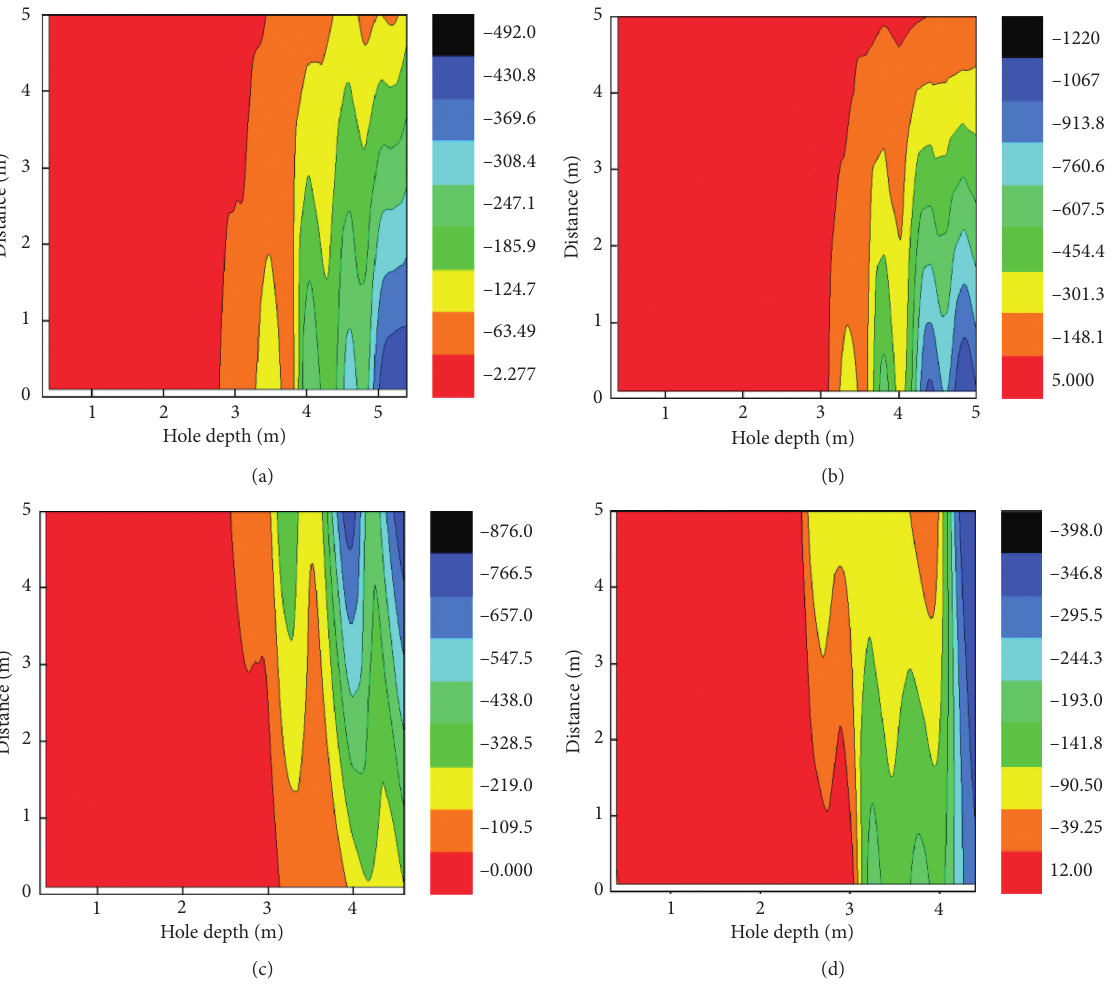
Figure 13: Nephograms of relative changes of ultrasonic wave velocity. (a) First blasting, (b) second blasting, (c) third blasting, and (d) fourth blasting (unit: